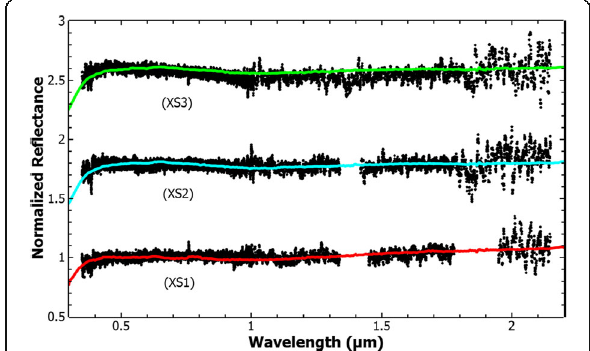
Fig. 4 The featureless/flatness nature of the Ryugu spectrum is evident in this series of three Vis-IR spectra. Superimposed are the spectra of thermally altered samples of the CM carbonaceous chondrite Murchison, in red (heated at 900 °C) and in cyan and green (heated at 1000 °C) (from Perna et al.